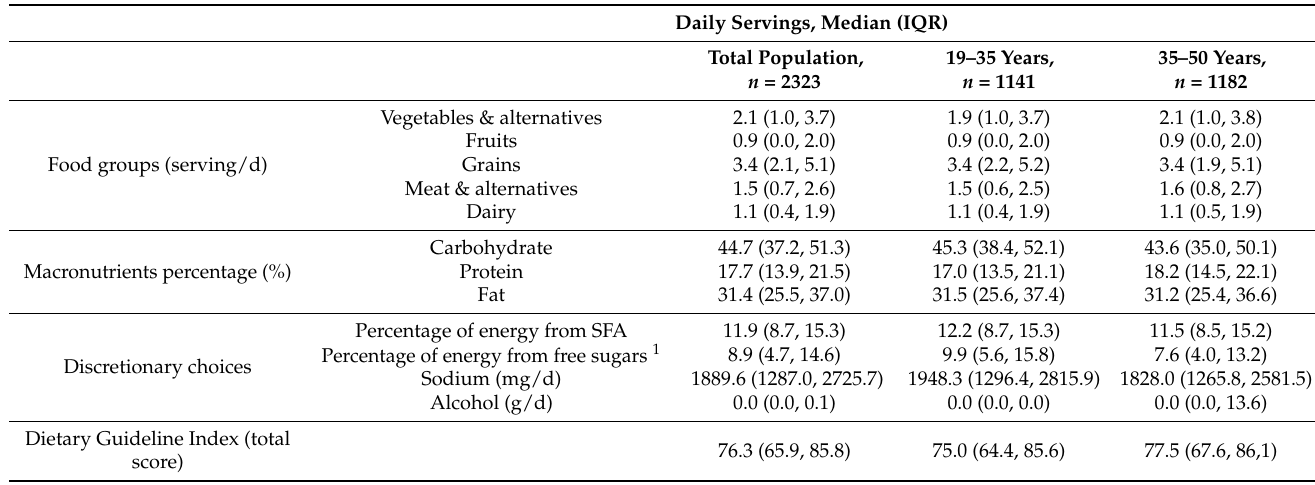
Table 2. Food group intakes for the whole population and by age group.